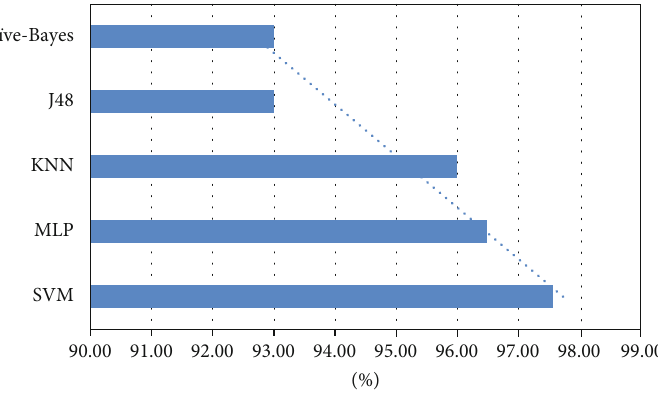
Figure 15: Comparison of classi fi